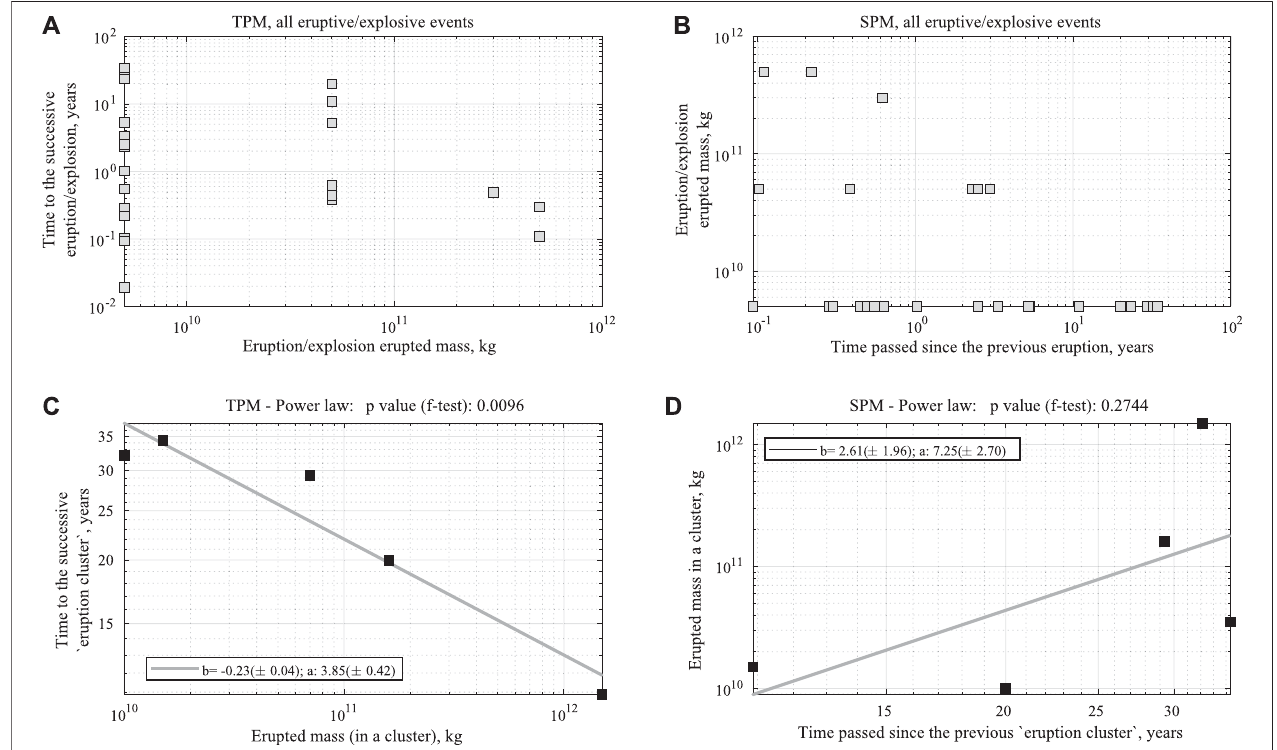
FIGURE 8 | (A) Plot of the relationship between time to subsequent eruptive event against the erupted mass (as for a time-predictable model) at a given time and considering each individual event. (B) Plot of the relationship between erupted mass at a given time against the time from the previous eruptive event (as for a size- predictable model) and considering each individual event. (C) The same as (A) but considering cluster events (i.e., time to subsequent cluster and the cumulative mass during a cluster and considering the 6-clusters partition). (D) The same as (B) but considering cluster events (i.e., cumulative mass during a cluster and time from previous cluster and considering the 6-clusters